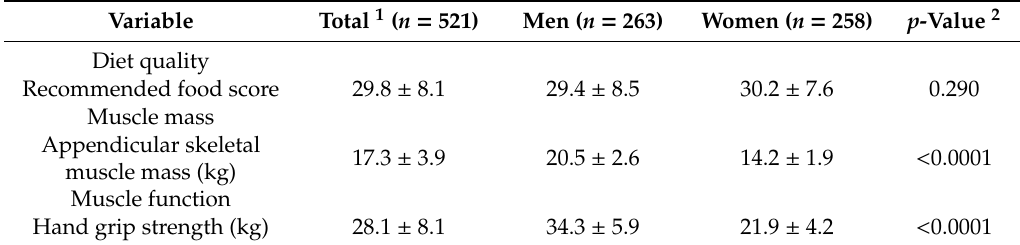
Table 2. Diet quality, and muscle mass and function of the subjects.